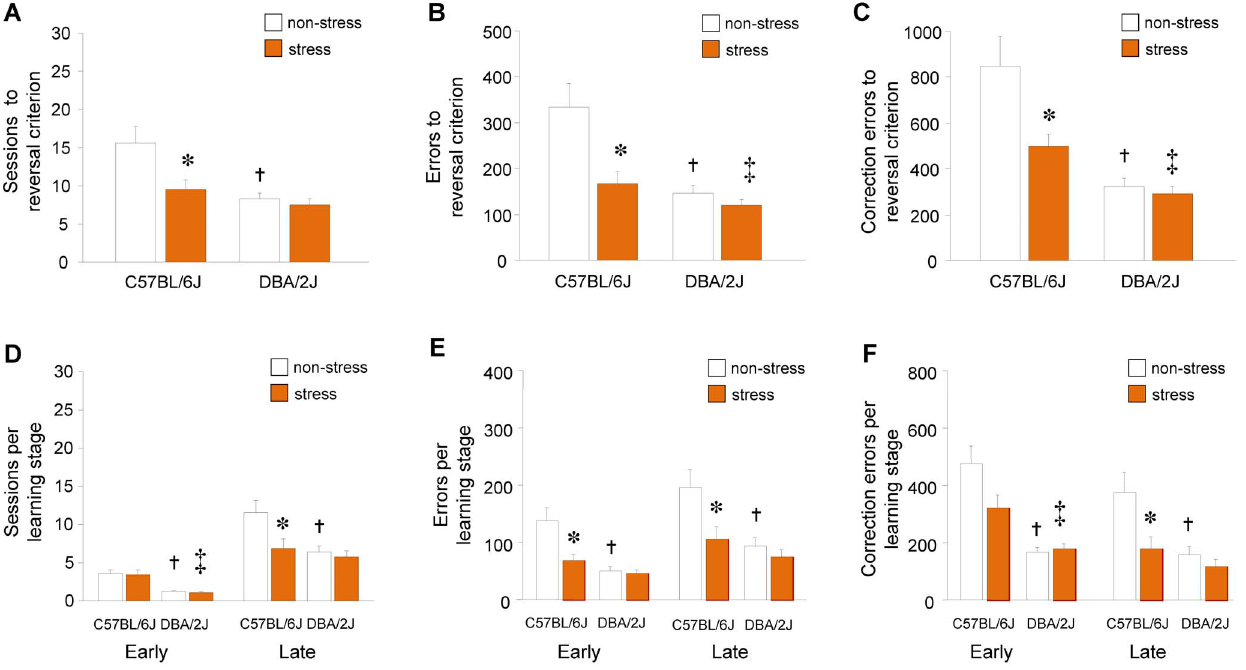
Figure 3. Stress effects on reversal learning in DBA/2J and C57BL/6J mice. ( A ) Sessions to reversal learning criterion. Errors ( B ) and correction errors ( C ) to reversal criterion. Sessions to early and late stage reversal ( D ). Errors ( E ) and correction errors ( F ) made during early and late stage reversal. * P , .05 stressed vs. non-stressed control C57BL/6J, { P , .05 non-stressed DBA/2J vs. non-stressed C57BL/6J, ` P , .05 stressed DBA/2J vs. stressed C57BL/6J. n=10–13 per stress group, per strain. Data are Means 6 SEM.